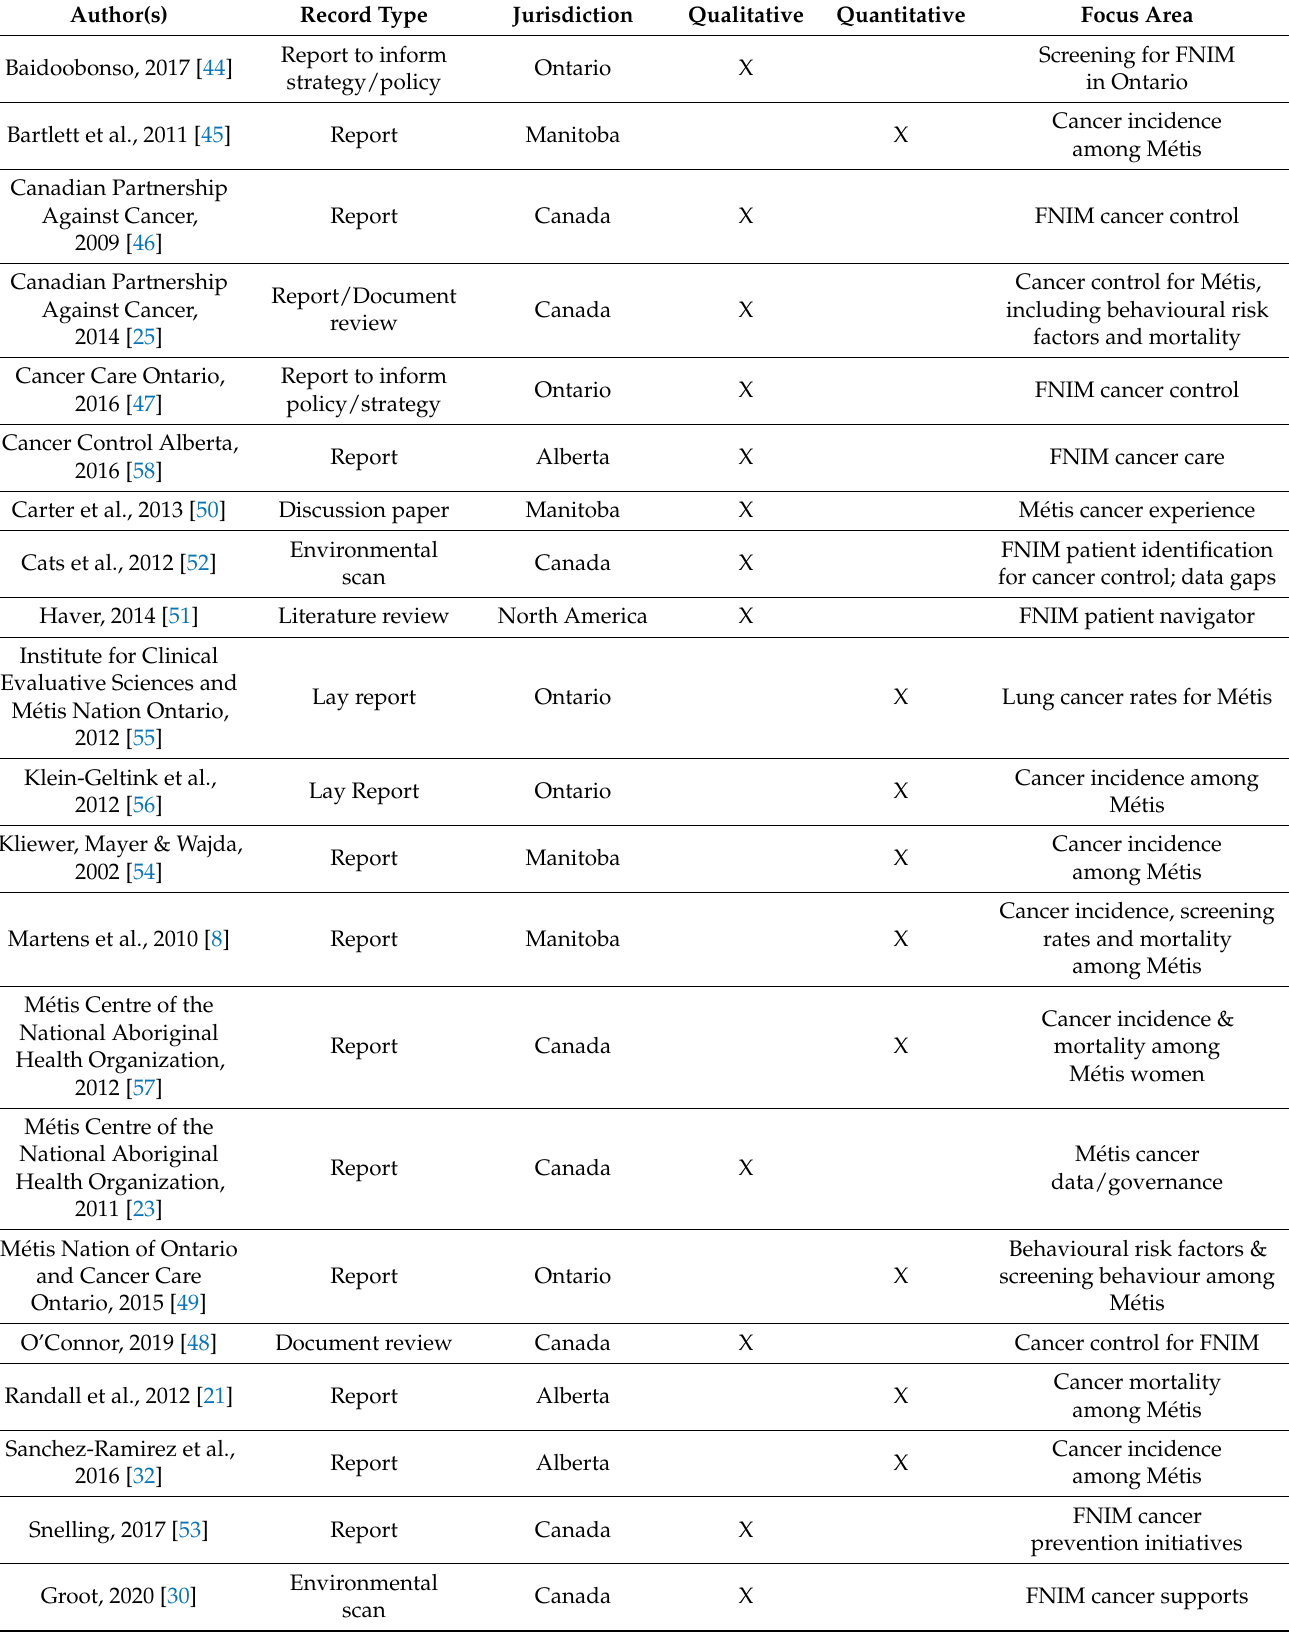
Table 5. Jurisdiction covered, record type, method used, and focus area of grey